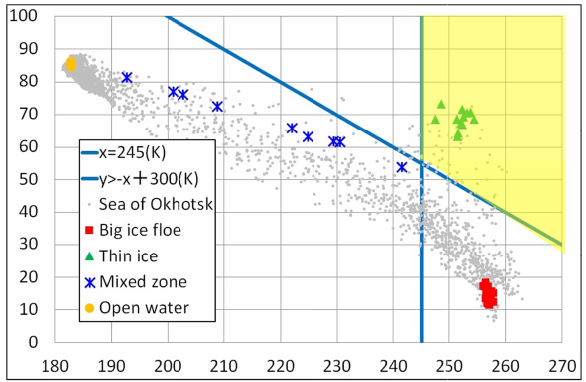
Figure Figure 4. Scatter plots of (19GHzV